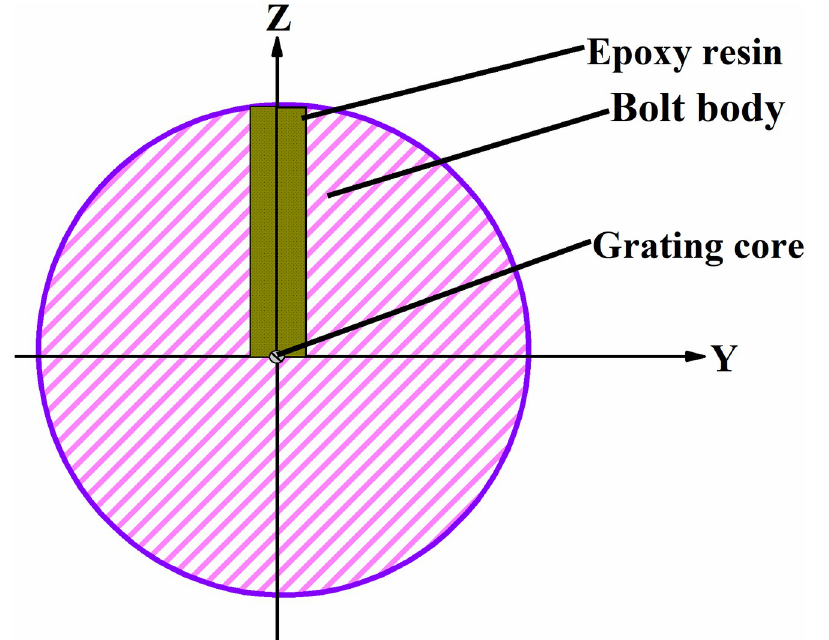
Fig 1. Schematic of FBG sensor embedded in the